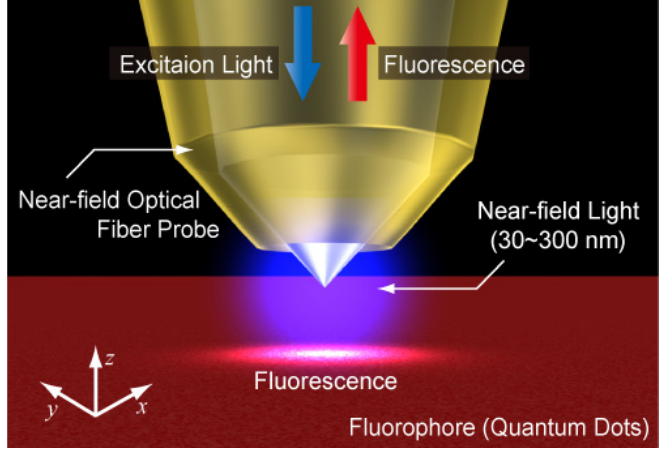
Figure 1. Schematic diagram of Fluor-NOTN. Quantum dots are utilized as temperature probes because of the temperature dependence of their fluorescence lifetime. Near-field light is utilized in order to achieve non-diffraction-limited spatial